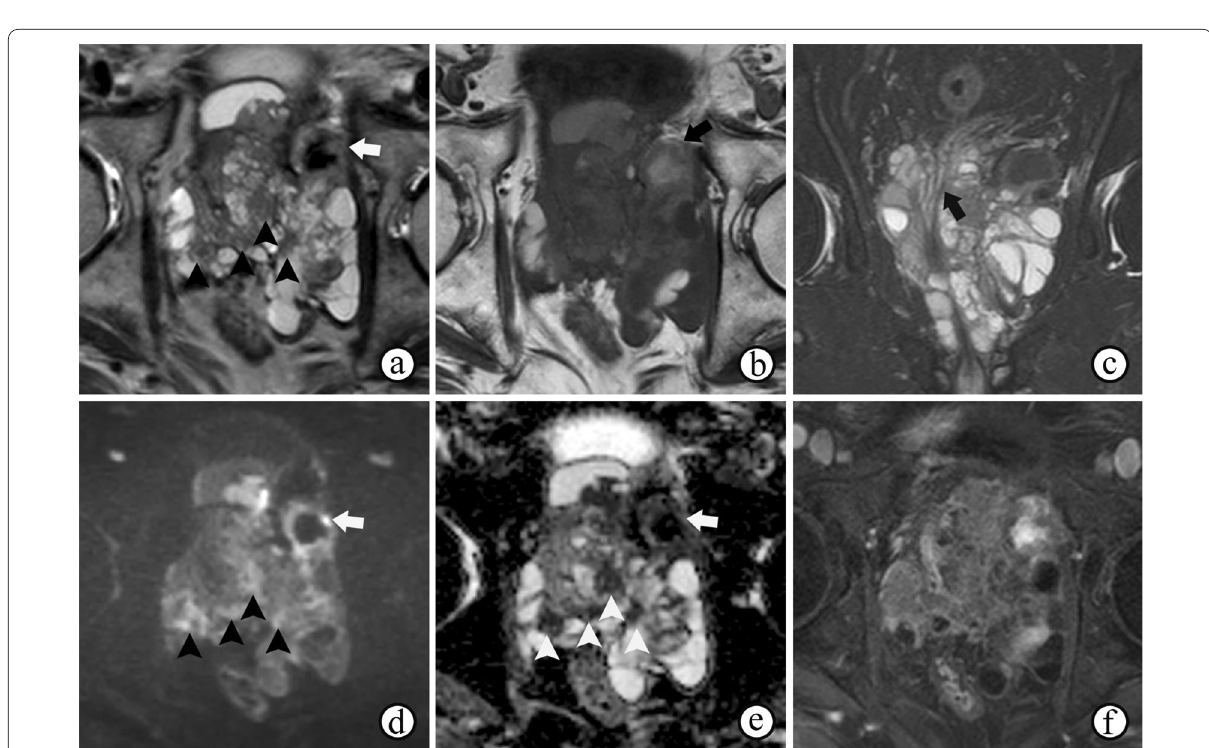
Fig. 8 Mixed ductal and acinar adenocarcinoma in an 87-year-old man with dysuria for 12 months and a serum PSA level of 30.24 ng/mL. a–c Axial T2-, axial T1-, and coronal fat-suppressed T2-weighted imaging show a multilocular cyst mass occupying the prostate, periprostatic fat and bilateral seminal vesicles (black arrow on c ), with heterogeneous signal intensity in cysts and multifocal solid areas (arrowheads on a ), and a cyst with a thick wall and a mural nodule (arrows on a, b ). d, e DWI at a b-value of 1000 s/mm 2 and ADC maps show inhomogenously restricted diffusion of the solid areas (arrowheads) and the thick wall (arrows). f DCE imaging shows heterogeneous enhancement of the